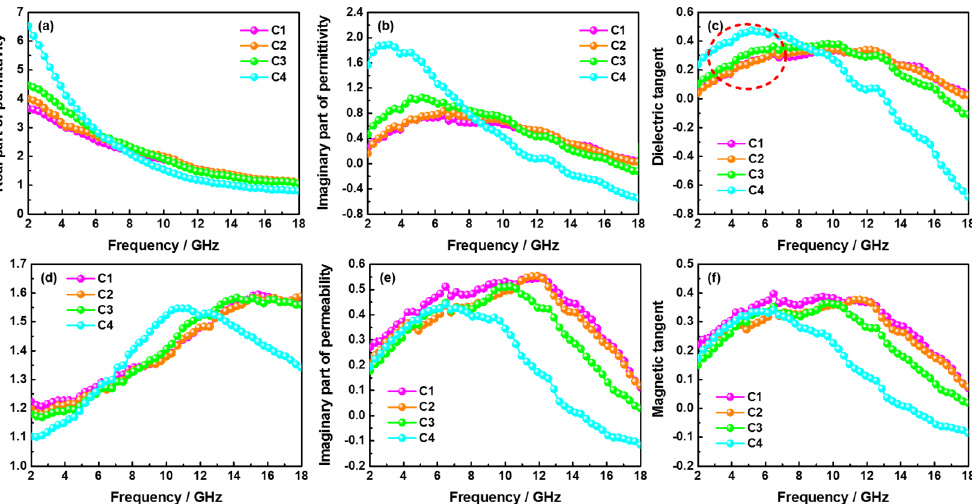
Figure 6. Permittivity ( a ) and ( b ), dielectric loss tangent ( c ), permeability ( d ) and ( e ), magnetic loss tangent ( f ) of C1–C4 composites.